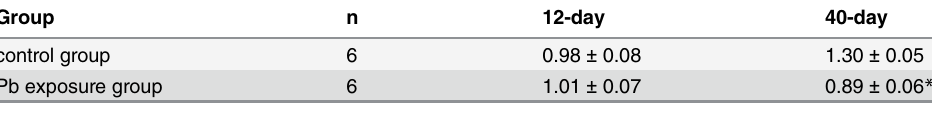
Table 1. The ratio of Bcl-2/Bax in vascular tissue in two